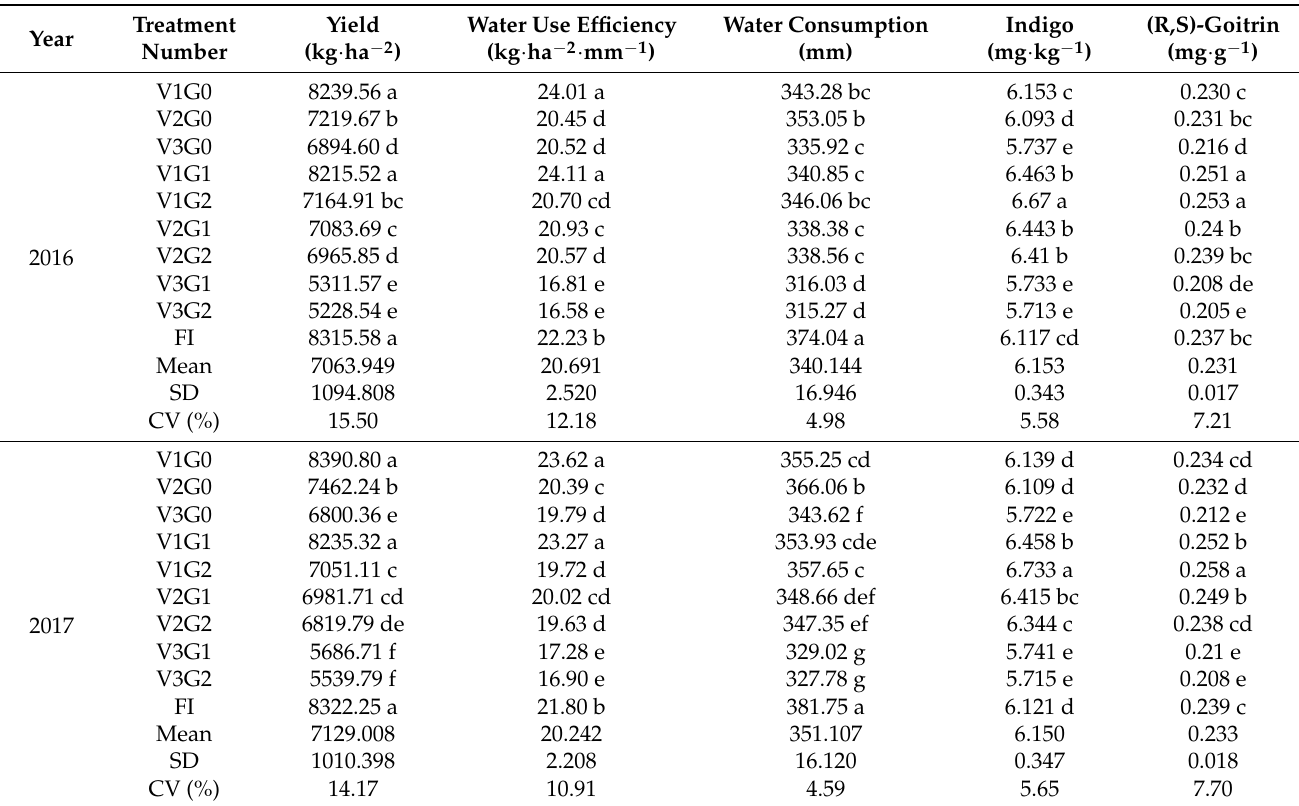
Table 4. Experimental results of the indicators for a comprehensive evaluation